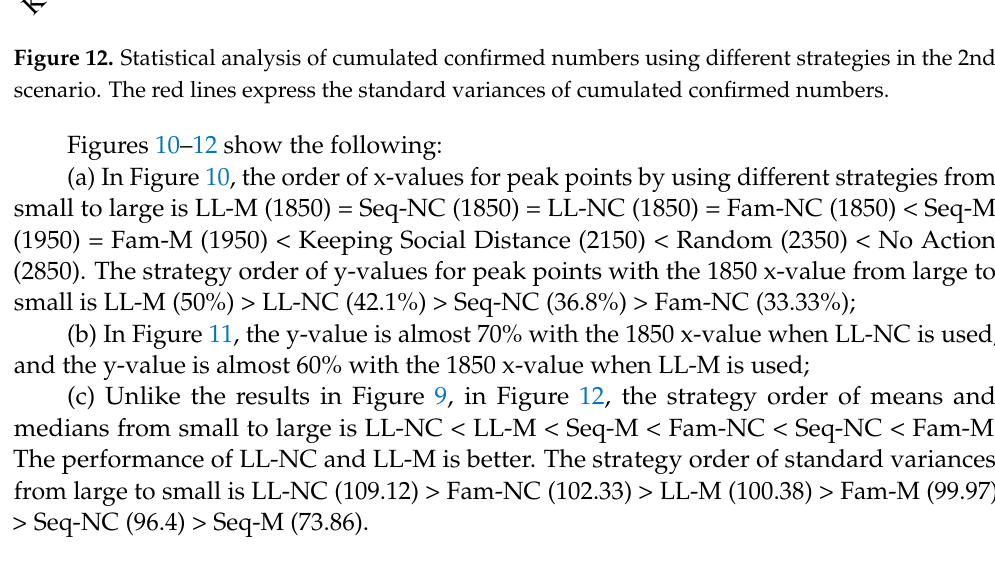
Figure 12. Statistical analysis of cumulated confirmed numbers using different strategies in the 2nd scenario. The red lines express the standard variances of cumulated confirmed numbers.